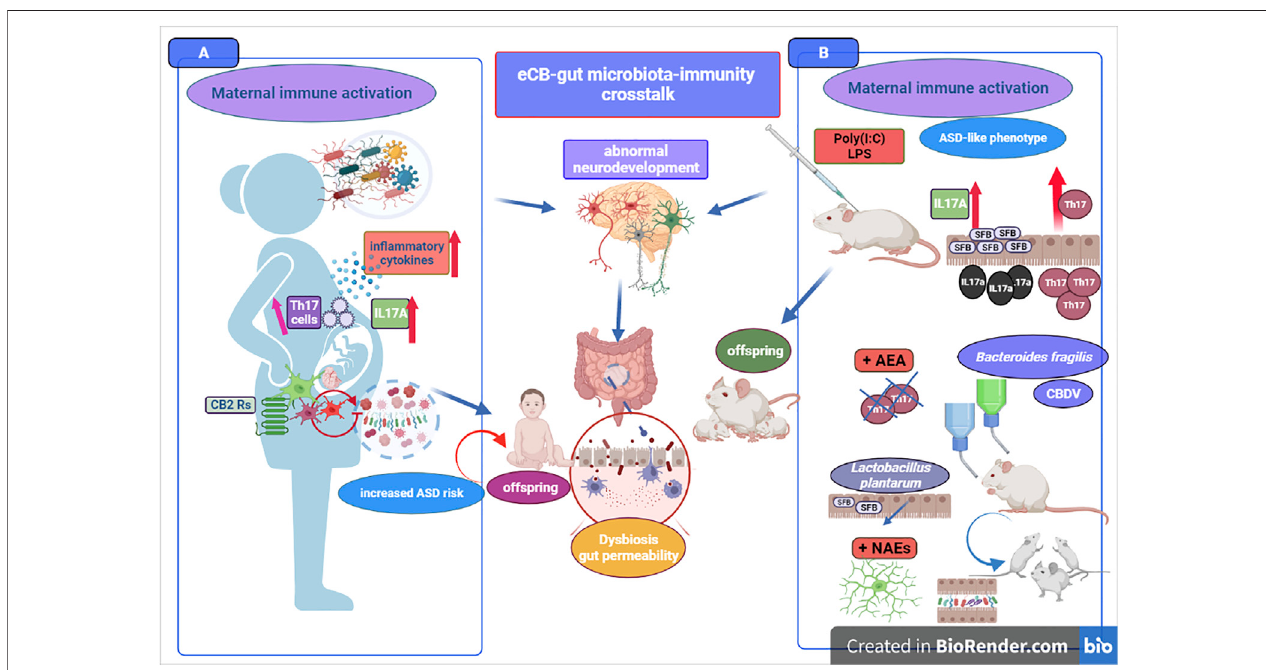
FIGURE 4 | The fi gure portrays some key elements of the eCB signaling-gut microbiota-immune system crosstalk. Immune dysfunction can be a driving pathogenetic mechanism in ASD, with a strong deleterious impact on neuroin fl ammation, neurodevelopment and derangement of gut microbiota. Maternal immune activation (MIA) in pregnant mothers (A) and MIA-induced ASD-like mouse model (B) are both paradigmatic of increased ASD risk. Pathogens-induced de fi cits of systemic immune-regulation 1 provides an elevated level of explanation and isomorphism between ASD risk in humans and its simulation in mice. On the left panel (A) , exposure to several types of infectious agents (e.g., herpes simplex virus type 2, cytomegalovirus) during pregnancy is responsible of immune activation and immune-regulatory de fi cits (e.g., auto-antibody production and/or increase of Th17 cells) as well as of the overproduction of maternal in fl ammatory cytokines (e.g., IL17A). Immune-regulatory dysregulation during pregnancy contributes to maternal dysbiosis and altered microbiota composition, with detrimental impact on fetal microglia motility and states of activation of microglial cells. The neuroin fl ammatory maternal and fetal environment elevates the risk of abnormal neurodevelopment and ASD diagnosis with offspring showing marked derangement of gut microbiota. On the right panel (B) , the ASD-like MIA mouse model corroborates the hypothesis of early developmental and in fl ammatory adverse events in ASD etiology. Abnormal neurodevelopment, microglia morphological alterations and changes of offspring gut microbiotaarecommonmechanismsinhumansandmicemodels.Pro-in fl ammatoryandimmunechallenges(e.g.,Poly(I:C),LPS)triggerneurodevelopmentalde fi citsin the offspring, with alteration of sociability and chronic neuroin fl ammation. For instance, microbiota segmented fi lamentous bacteria (SFB) produce an increase of Th17 activation (including IL17a production) but mice lacking SFB do not develop ASD-like symptoms. L. plantarum decreases SFB and supplementation with Bacteroides fragilis induces recovery from social communication de fi cit and damage to intestinal permeability. The crosstalk between eCBs bioactive lipids and ASD is further supported by the shift of microglia towards an anti-in fl ammatory phenotype and improve of ASD symptoms following the increase of NAEs-mediated signaling.